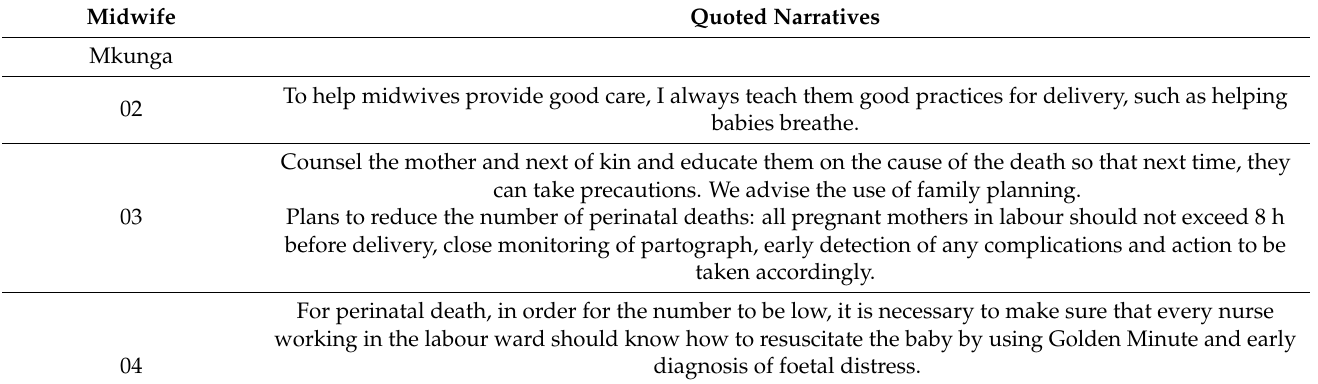
Table 2. Quotations from midwives focused on education and care strategies used to prevent Very Early Neonatal